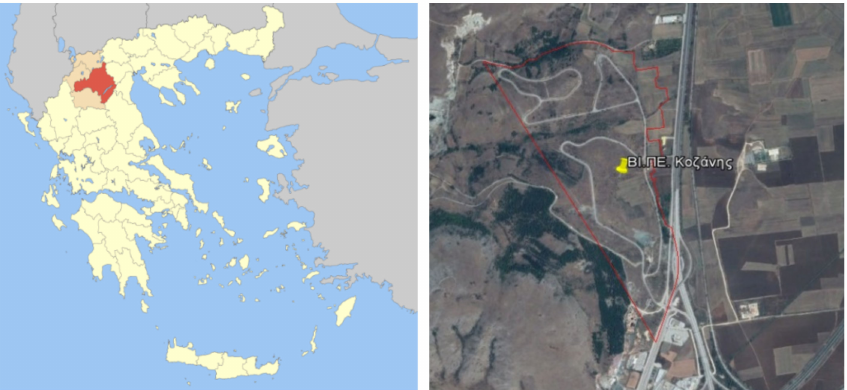
Figure 6. Location of Western Macedonia business park. Source: Environmental impact assessment study for the development of Kozani’s business park [91]. Table 7. Investigation for the application of environmental indicators (see Table 6) into the upcoming Western Macedonia business park (WM